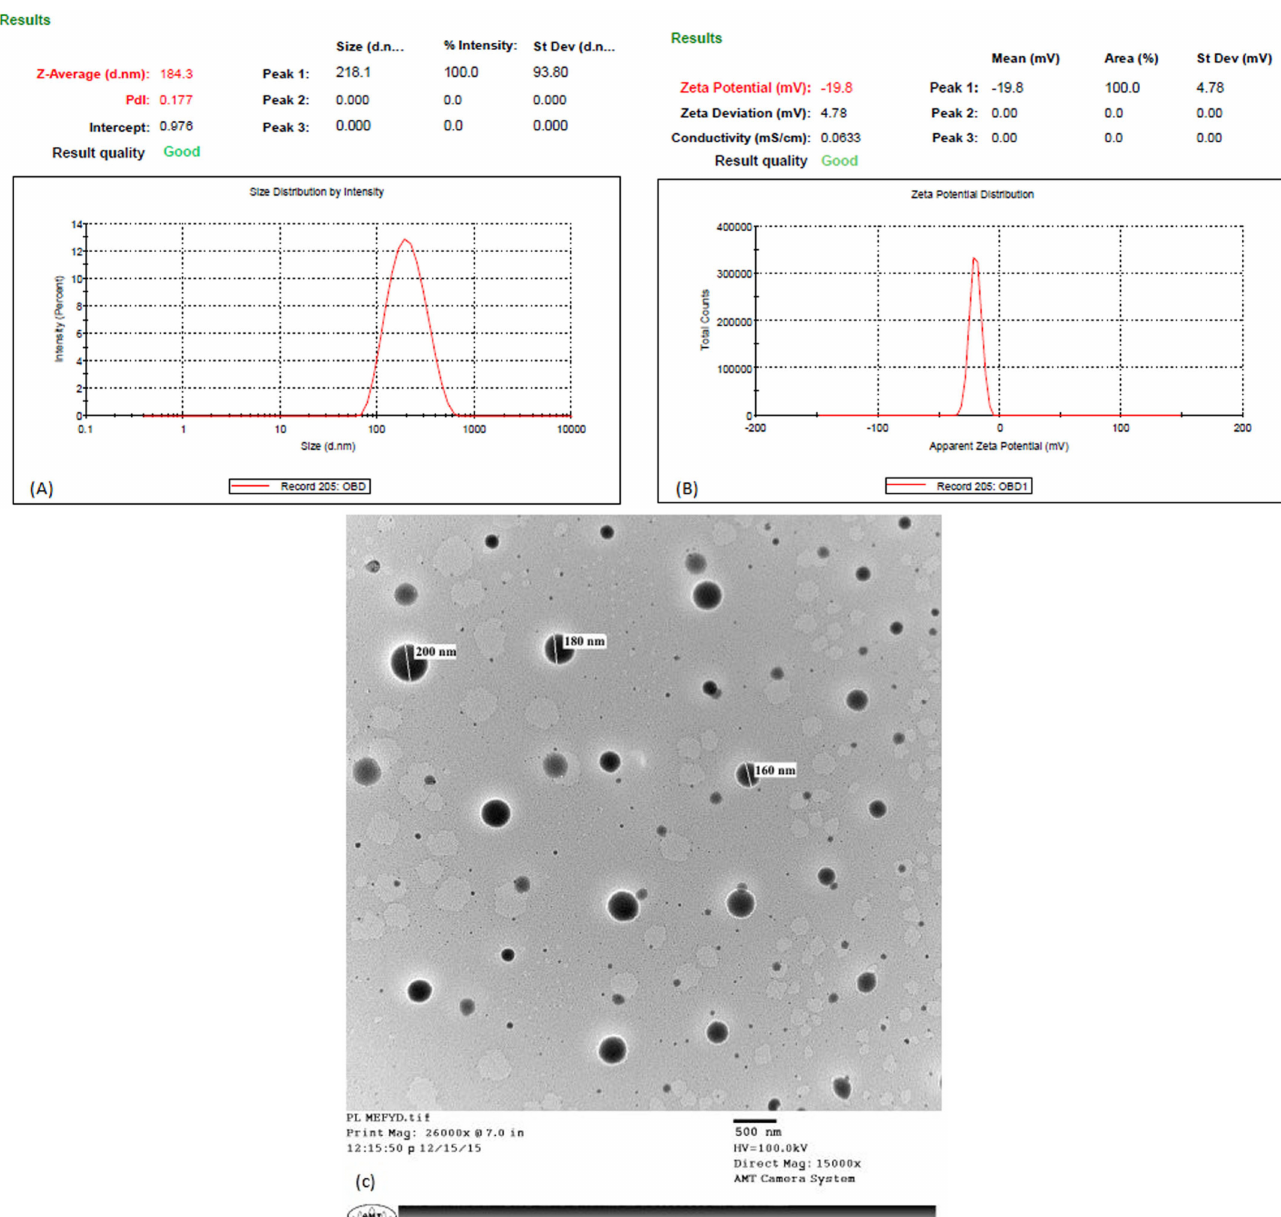
Figure 1. ( A , B ) Particle size of baicalin-loaded LPHNPs and zeta potential, respectively. ( C ) Electron transmission microscopy (TEM) of baicalin-loaded